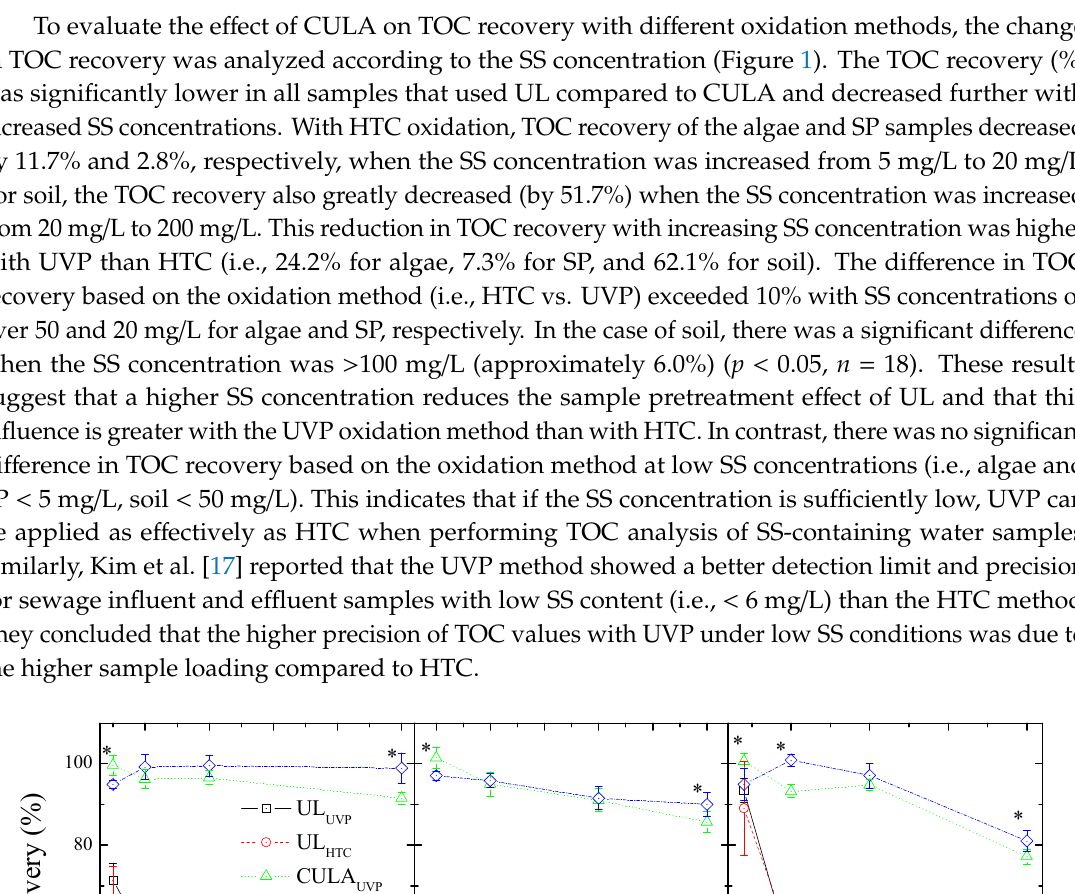
Figure 1. Changes in total organic carbon (TOC) recovery (%) of water samples containing particles from different origins compared between different pretreatment methods (UL: ultrasonication only, CULA: combined ultrasonic and alkali pretreatment), oxidation methods (UVP: UV-persulfate, HTC: high-temperature combustion), and suspended solids (SS) concentration: ( a ) Algae; ( b ) Sewage particles (SP); and ( c ) Soil. * indicates a statistical difference between UL and CULA pretreatments ( p < 0.05, n = 18).